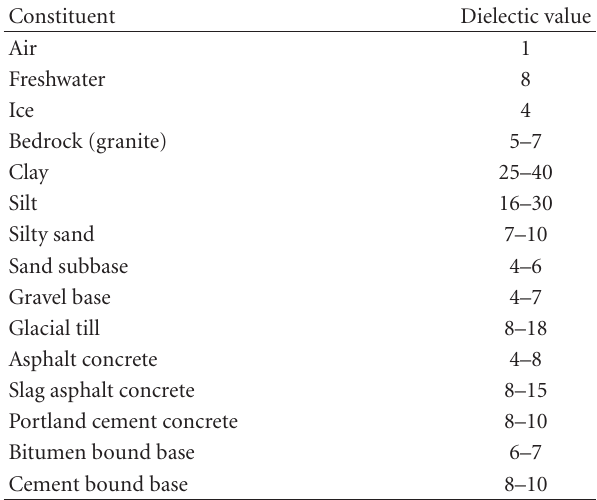
Table 1: Dielectric values of typical road soil and layer